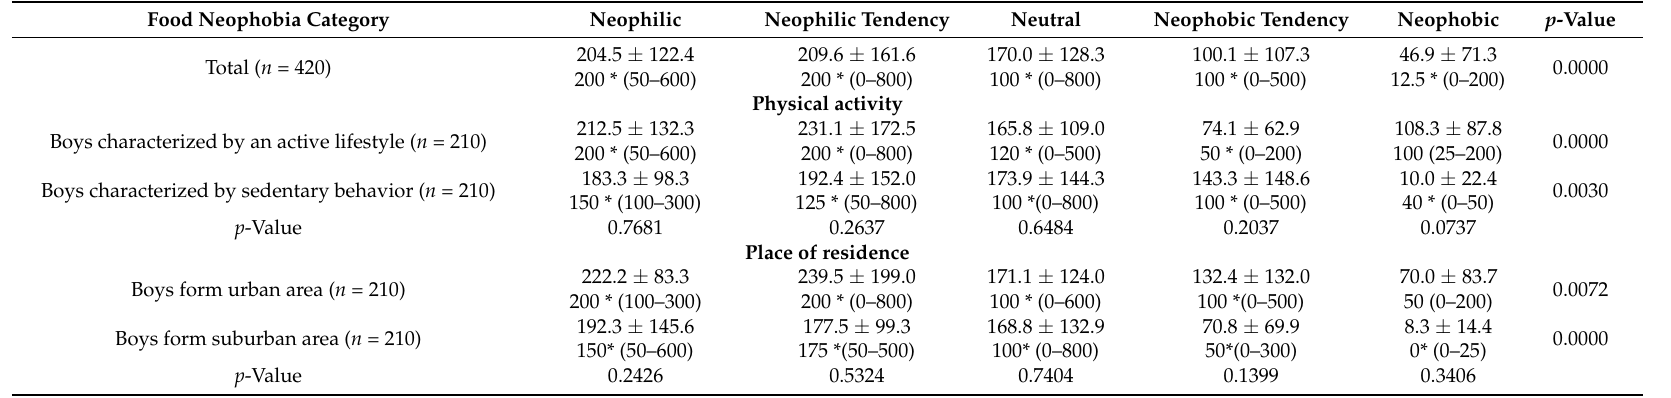
Table 1. Vegetable intake (g/day) for boys in Food Neophobia Scale categories—mean ± standard deviation (SD), as well as median, minimum, and maximum values are presented for food neophobia categories and compared between subgroups characterized by an active lifestyle ( n = 210) and by sedentary behavior ( n = 210), as well as from urban area ( n = 210) and suburban area ( n =